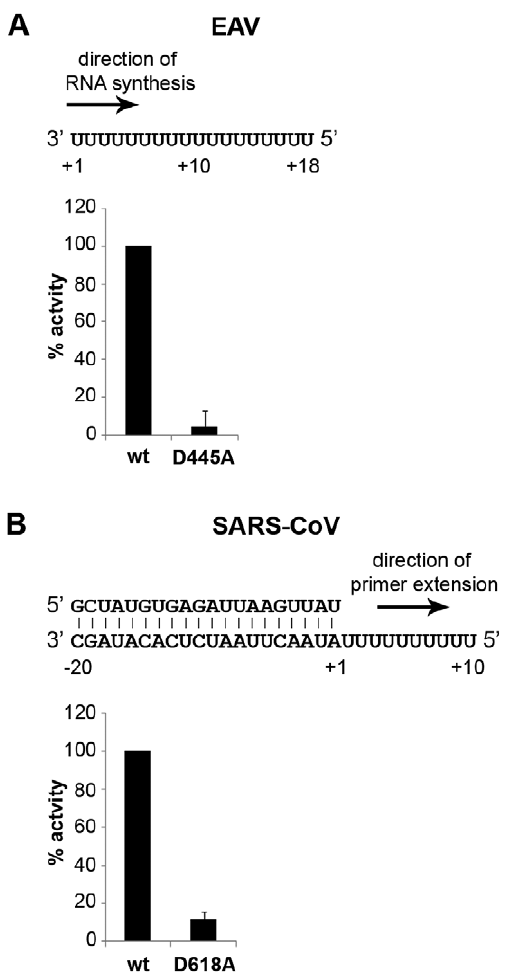
Figure 4. EAV and SARS-CoV RdRp assays with wild-type enzyme and active-site mutants. ( A ) The EAV polymerase was incapable of primer extension and required a free 3 9 end and poly(U) residues to initiate. Nucleotide incorporating activity of the wild-type enzyme and D445A mutant of nsp9 on an 18-mer poly(U) template confirmed the specificity of our assay. ( B ) SARS-CoV nsp12 RdRp assays were performed with an RNA duplex with a 5 9 U 10 overhang as template. The bar graph shows the nucleotide incorporating activities of wild-type and D618A nsp12. Error bars represent standard error of the mean